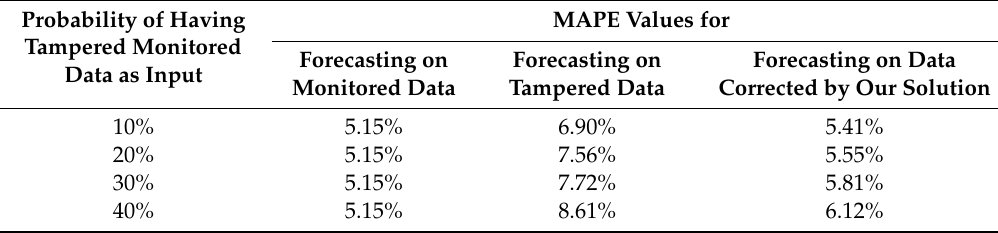
Table 3. MLP prediction accuracy on tampered energy